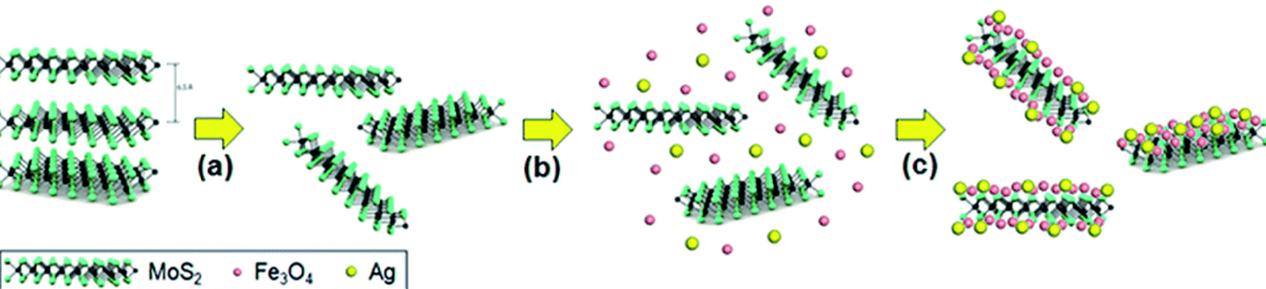
Figure 1. Schematic representation of ( a ) Liquid-phase exfoliation of MoS 2 powder into nanosheets in NMP by sonication; ( b ) mixing of MoS 2 nanosheets with Fe 3 O 4 @OA and Ag@ODA NPs ( c ) spontaneous hierarchical co-assembly of NPs on MoS 2 nanosheets through van der Waals in- teractions. Reproduce with permission of ref. [71]. Copyright 2015, Royal Society of